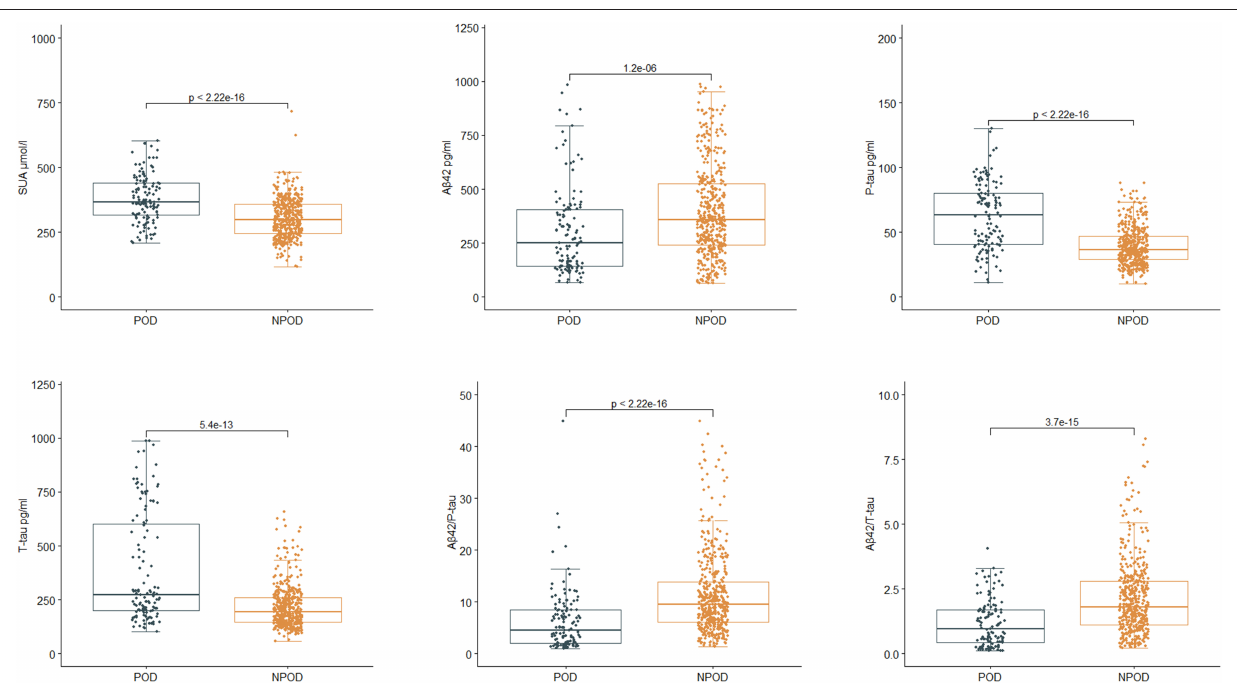
FIGURE 4 | Relationship between SUA, cerebrospinal fluid (CSF) Alzheimer-related biomarkers, and POD in PNDABLE. SUA, CSF phosphorylated tau (P-tau), and CSF total tau (T-tau) were increased in POD group ( P < 0.001), while CSF β -amyloid42 (A β 42 ), CSF A β 42 /P-tau and CSF A β 42 /T-tau were decreased ( p <